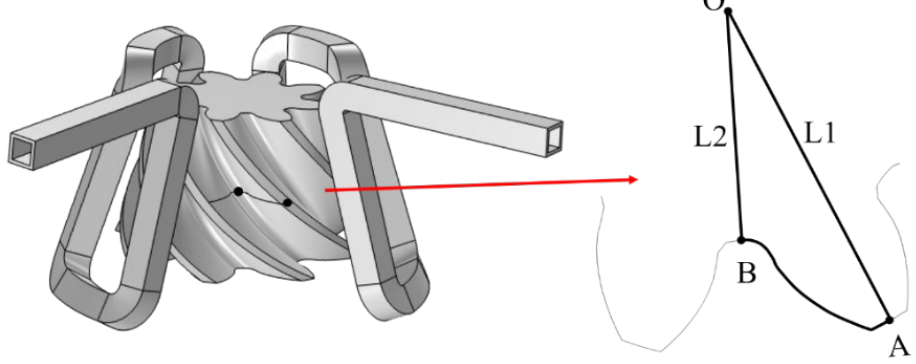
Figure 17. Schematic diagram of tooth root and tooth top research points.